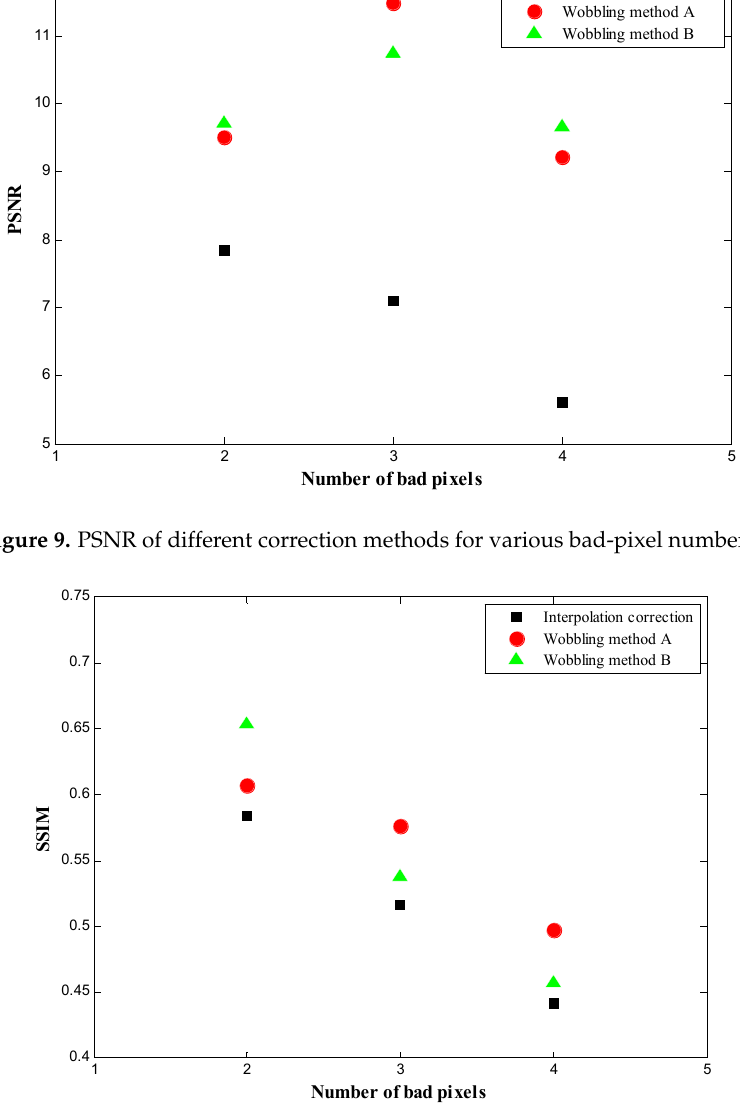
Figure 10. SSIM of different correction methods for various bad-pixel numbers.